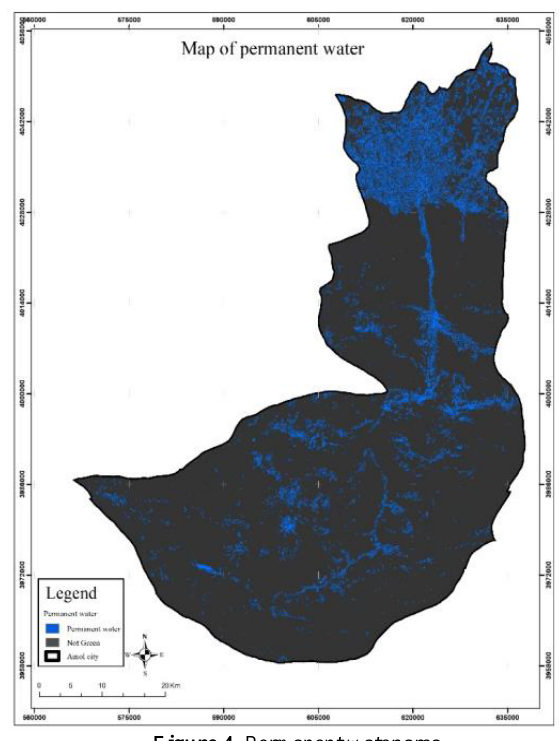
Figure 4 . Permanent water